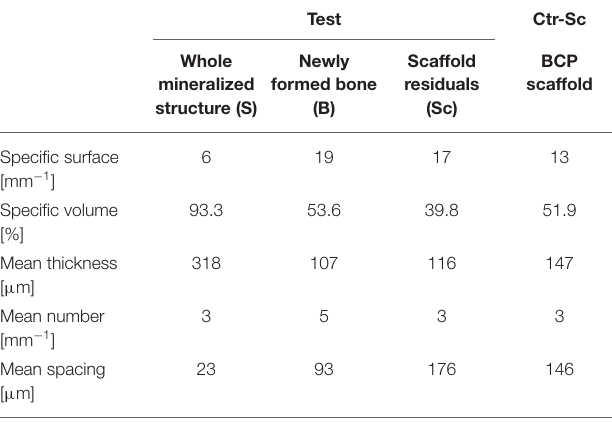
TABLE 1 | Study of microarchitecture in the test-maxillary biopsy (Test) retrieved after 7 years in-vivo : whole Mineralized Structure (S), Newly Formed Bone (B), and Scaffold Residuals (Sc) were considered.